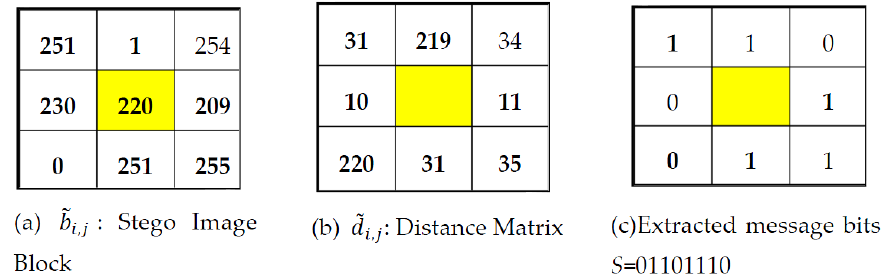
Figure 3. Message extraction process.